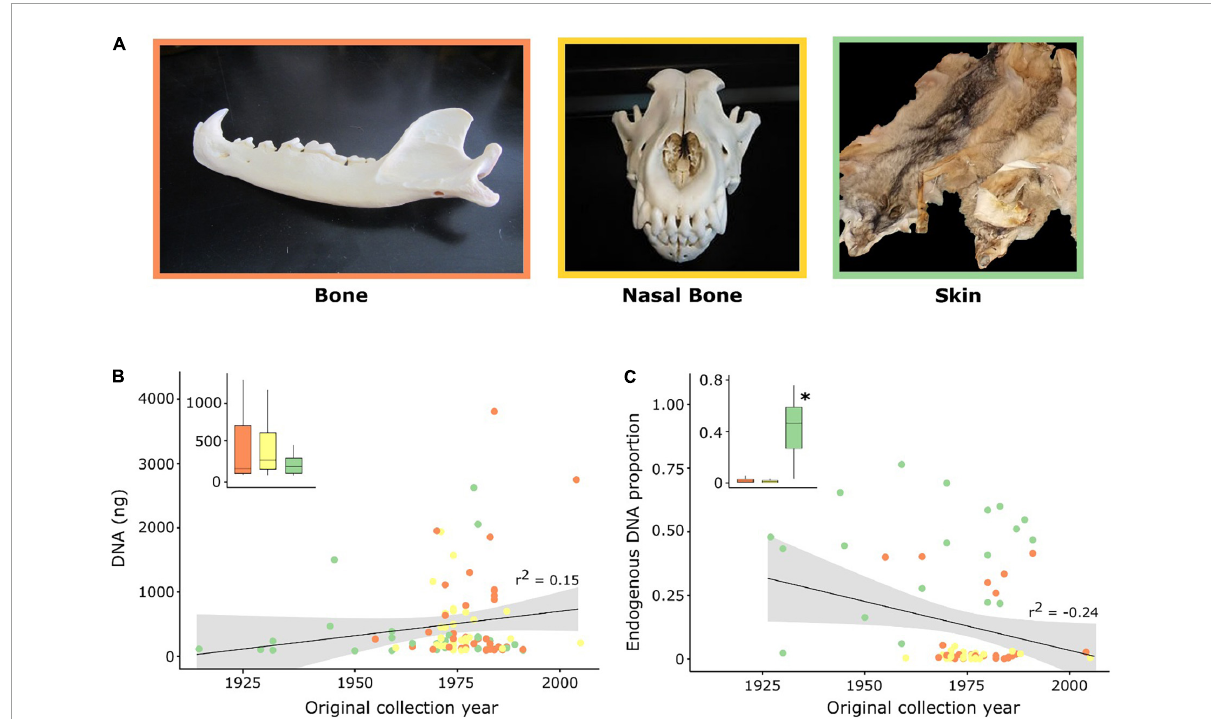
FIGURE1 Characterization of samples and hDNA used in this work. (A) Photographs illustrating the specimens used for the collection of each tissue type (Image credits Raquel Godinho). (B,C) Correlation (r 2 ) between DNA yield (ng) following extraction and the proportion of endogenous DNA content with the original collection date of the specimens. Each dot represents a historical sample and inset boxplots display the median (central line) and distribution per tissue type. Significant differences ( p < 0.05) between tissues are identified with an asterisk. Colors depict the three different tissue types used in this study: orange—bones (jaw and femur); yellow—maxilloturbinal (nasal) bones; and,